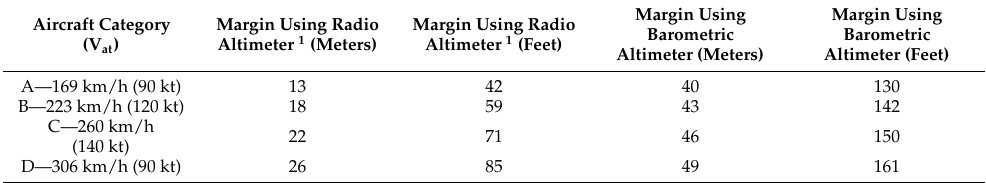
Table 9. Height loss margins. Source: ICAO PANS-OPS.